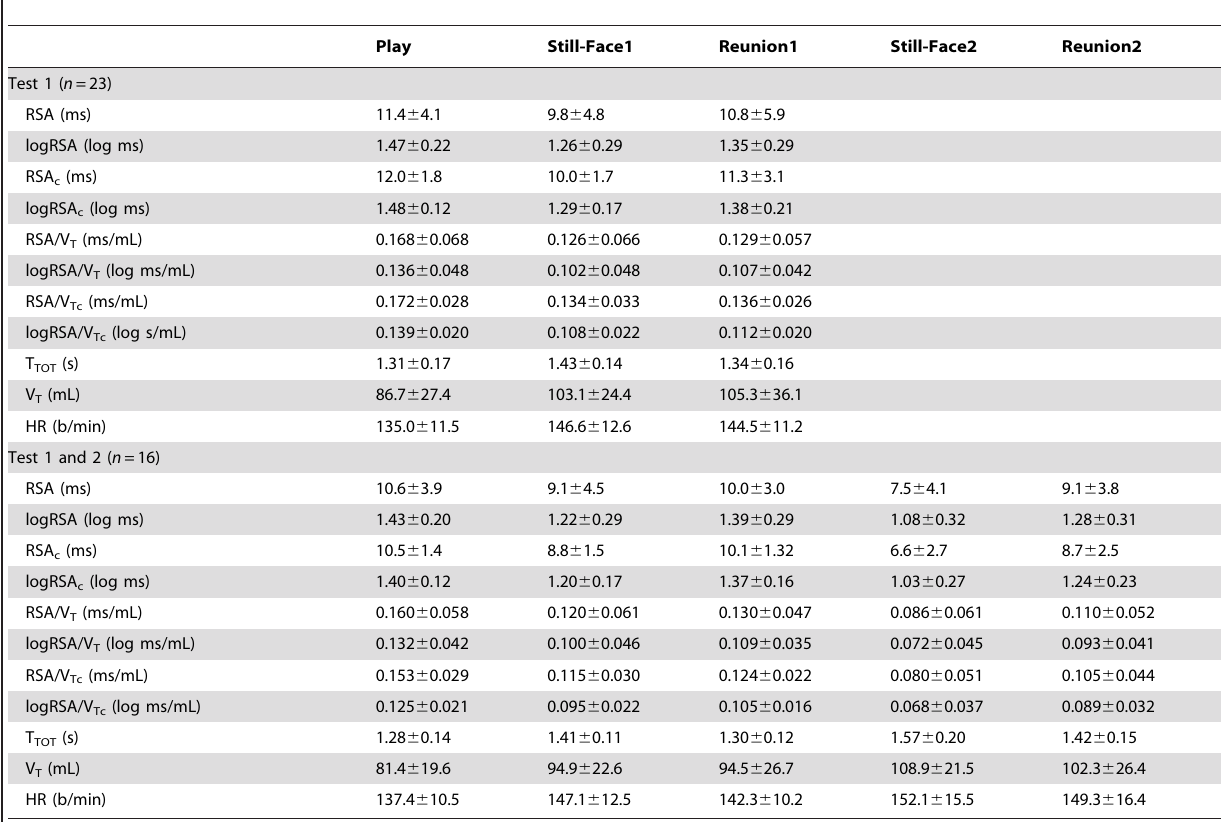
Table 2. Means 6 standard deviations of respiration-uncorrected and respiration-corrected RSA indices, respiration measures, and HR for Still-Face Test